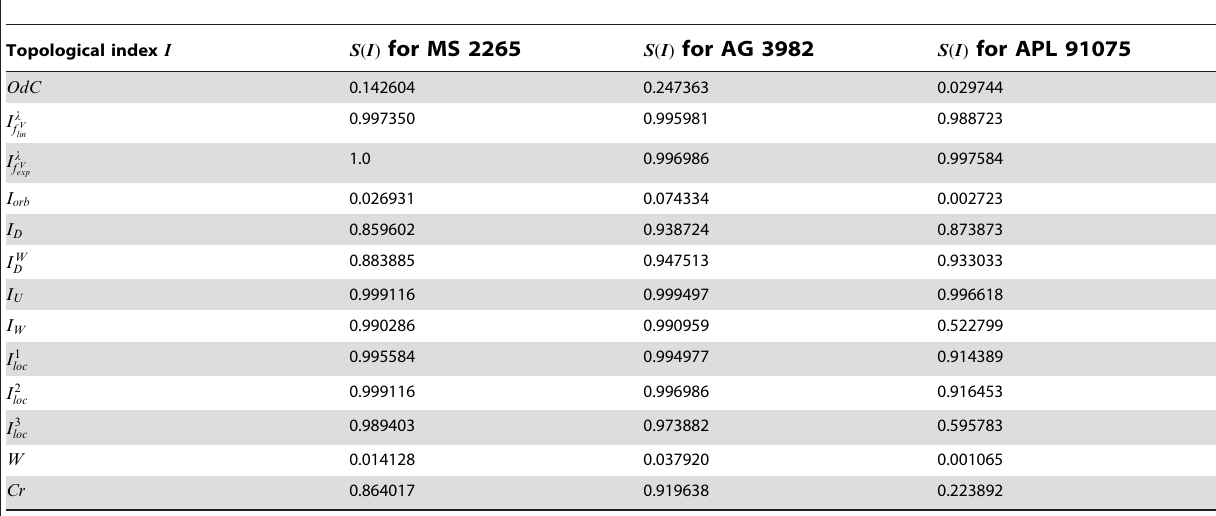
Table 1. Calculation of sensitivity index S ( I ) for chemical